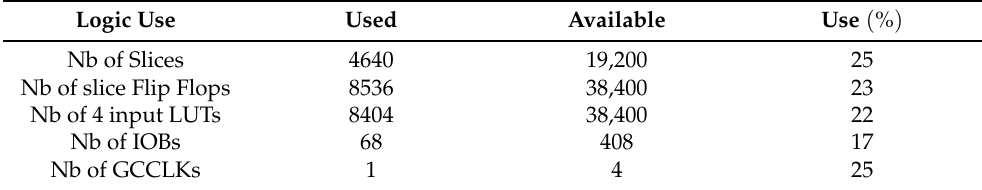
Table 6. Hardware resource utilization of the design (Part 2: CORDIC_IP) Logic Use Used